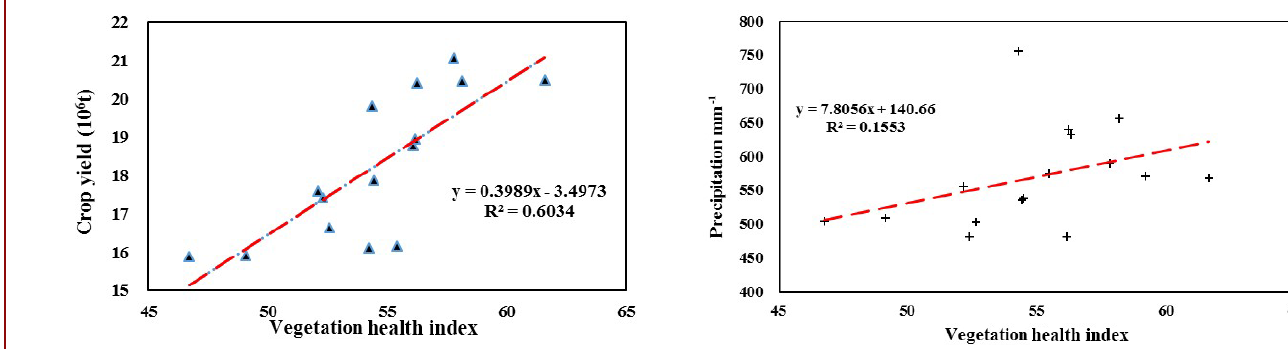
Figure 11. Correlationship between precipitation and the VHI dur- ing 2000–2015 in the Wei River